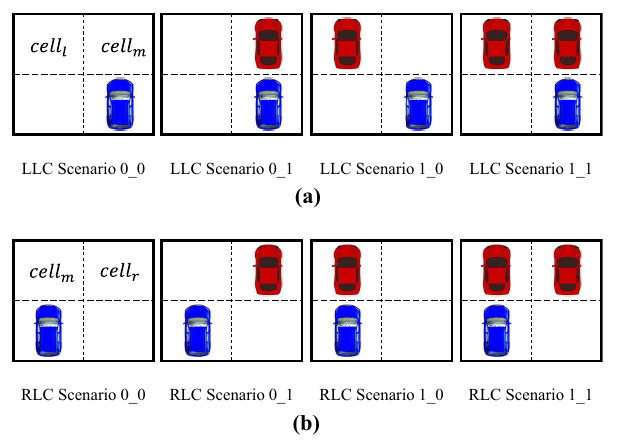
Figure 2 Illustration of the occupancy cells LC scenarios